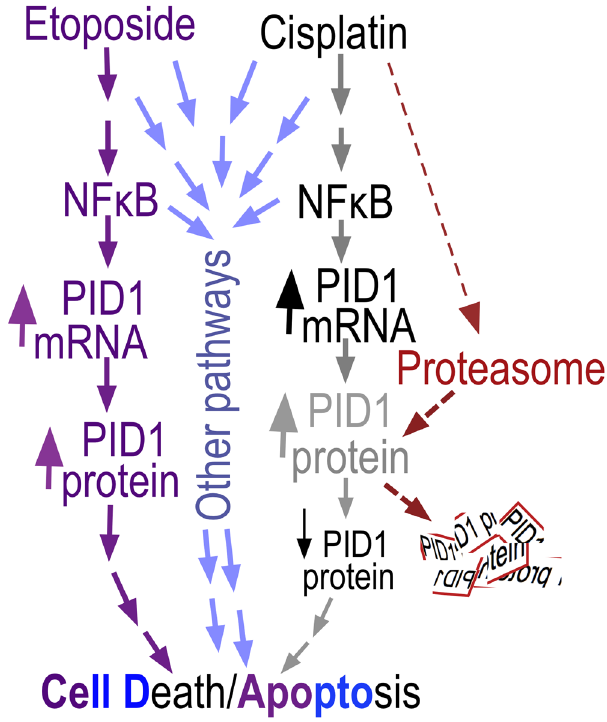
Figure 6. PID1 in chemotherapy-induced medulloblastoma and glioma apoptosis. The data suggest that PID1 contributes to chemotherapy-induced apoptosis through an NF κ B-dependent mechanism as follows: Etoposide and cisplatin both increase PID1 mRNA via NF κ B and both increase apoptosis. While etoposide increases both PID1 mRNA and PID1 protein, cisplatin increased PID1 mRNA, but decreased PID1 protein. The cisplatin-induced decrease in PID1 protein is reversed by bortezomib, suggesting that it is due to proteasomal degradation. It is likely that both etoposide and cisplatin activate additional signaling pathways that contribute to